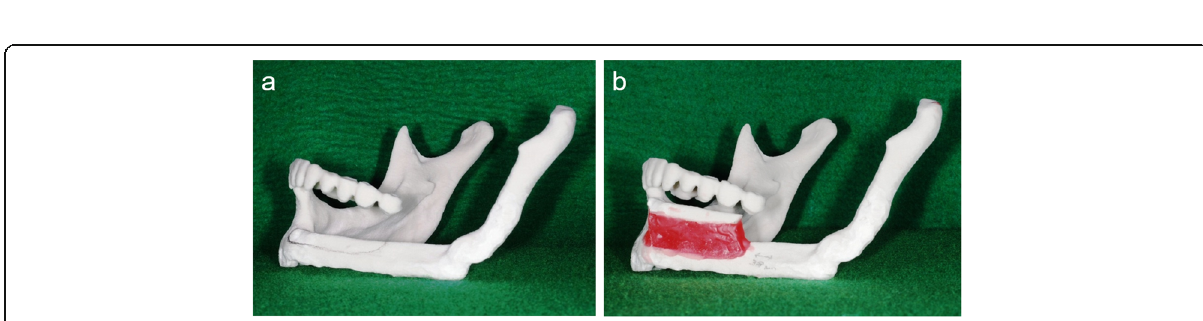
Fig. 9 a , b Surgical simulation using a 3-D model